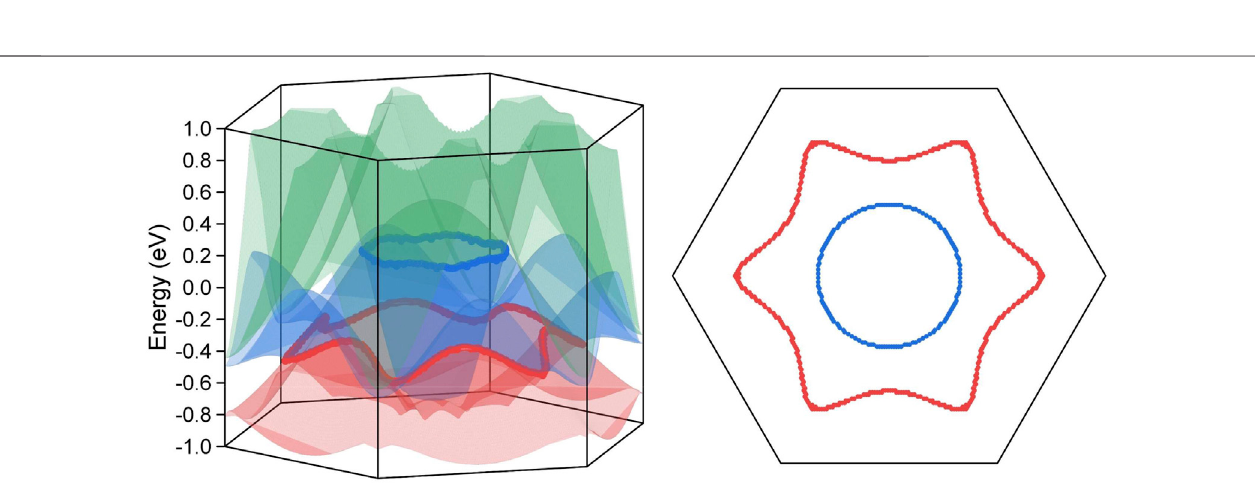
FIGURE3| Theillustrationof (A) thelocationanddistributionofthetwoWeylnodalringsalongthek z (cid:2) 0planeand (B) thetwoDiracnodallinesalongthek z (cid:2) π the plane. The high symmetry points and paths are also displayed for enhanced visualization.